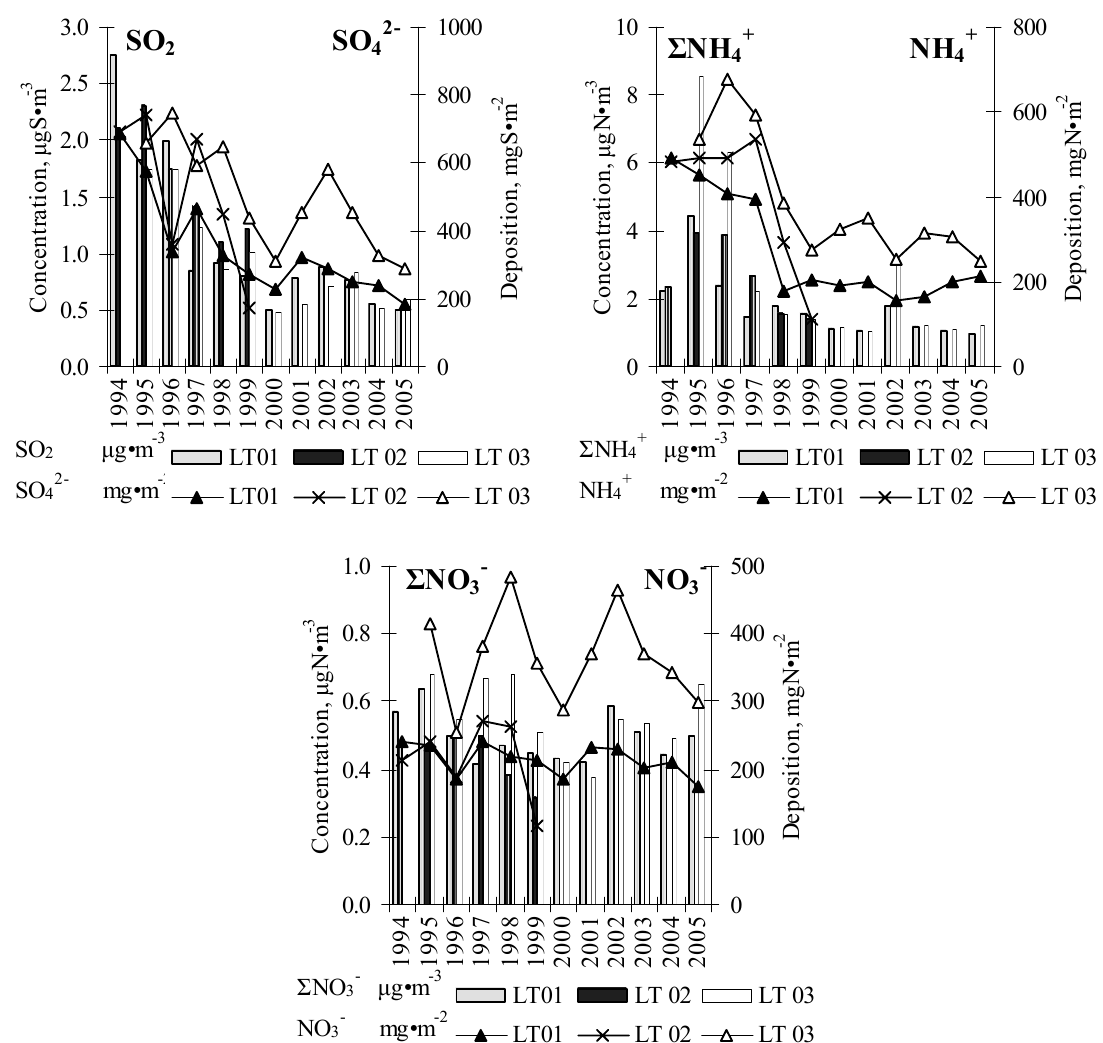
FIGURE 1. Air concentrations of the considered pollutants ( ▓ ) and their deposition